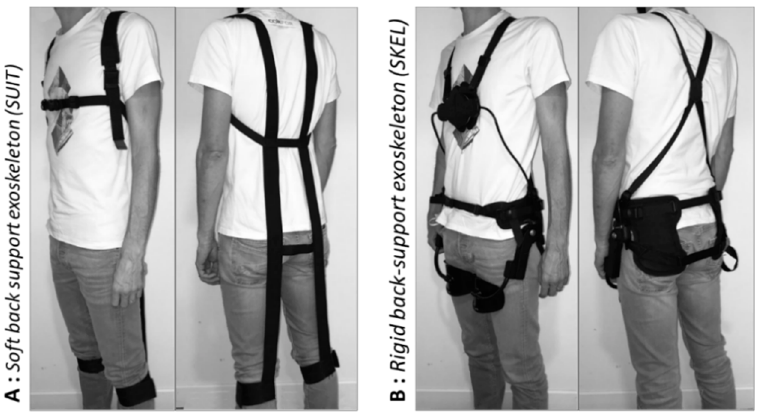
Figure 2. The two exoskeletons used; ( A ) soft back-support exoskeleton or exosuit (SUIT) (Corfor ® - V2, Villemus, France), and ( B ) rigid back-support exoskeleton (SKEL) (Laevo ® -V1, Deft, The Neth- erlands). The